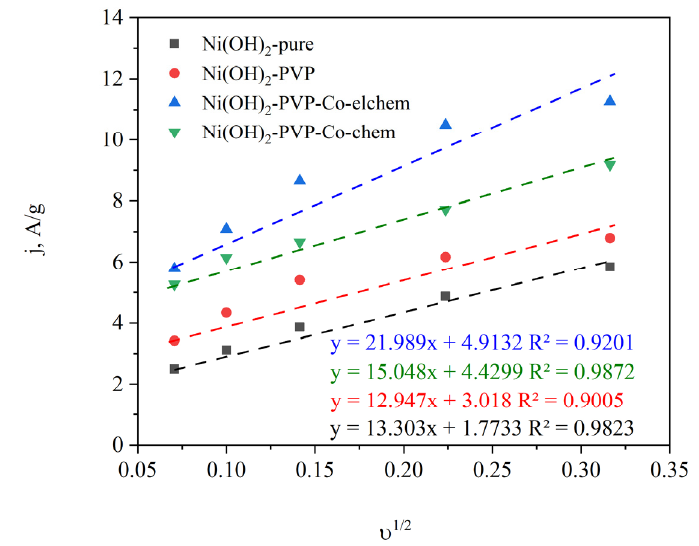
Figure 9. Dependence between the specific cathodic currents of the peaks and the sweep rate roots.